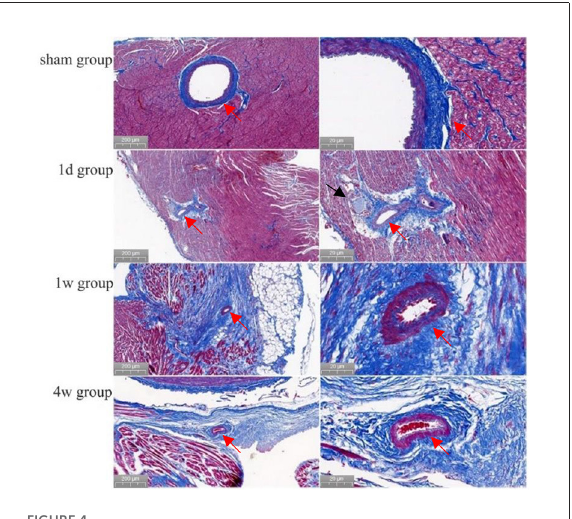
FIGURE4 Morphology of cardiac vessels and nerves in the ablation area (Masson staining). Preoperatively, the endothelial cells of the arterial vessels were neatly and closely arranged with well-defined layers. Then, at 1 day, 1, and 4 weeks after ablation, no abnormal changes had occurred in the arterial vessels or endothelial cells (shown by red arrows). Also, at 1 day after ablation, the nerve structure was intact (shown by black